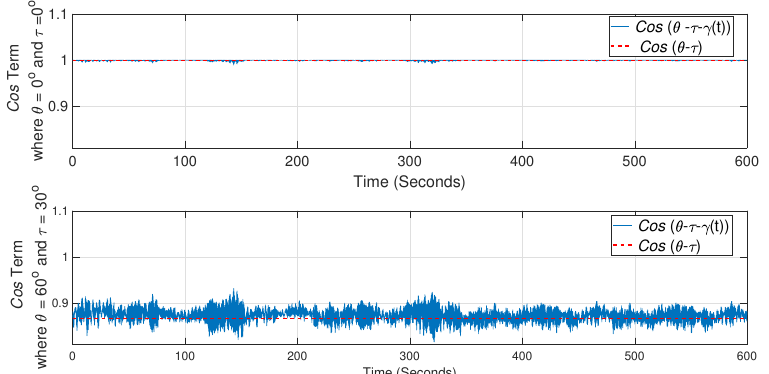
Figure 12. Cos term evaluation for a below-rated wind speed (6 m/s) for set θ = 0 ◦ , τ = 0 ◦ ( above ) and for set θ = 60 ◦ , τ = 30 ◦ ( below